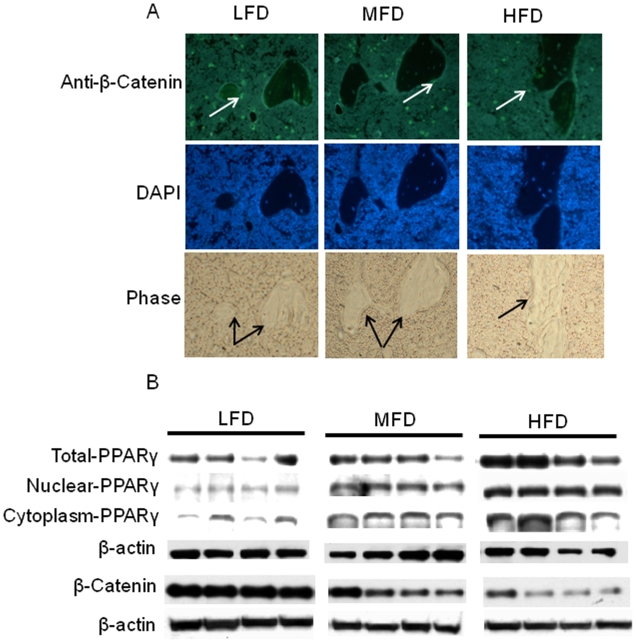
Increased PPARγ but decreased β-catenin protein expression in bone from HFD-induced obese rats.(A) Representative pictures of immunostained tibial bone sections using an anti-mouse β-catenin polyclonal antibody. White arrows indicate immunostained β-catenin, and black arrows indicate bone tissues. (B), Western blots of PPARγ (from total protein lysates, nuclear and cytoplasmic fractions), β-catenin and β-actin are depicted for four samples from LFD, MFD and HFD groups. LFD, low fat diet (control pelleted AIN-93G 14% fat diet); MFD, medium fat TEN diet (25% fat diet); HFD, high fat TEN diet (45% fat diet). Proteins were isolated from long bone after aspiration of bone marrow cells.